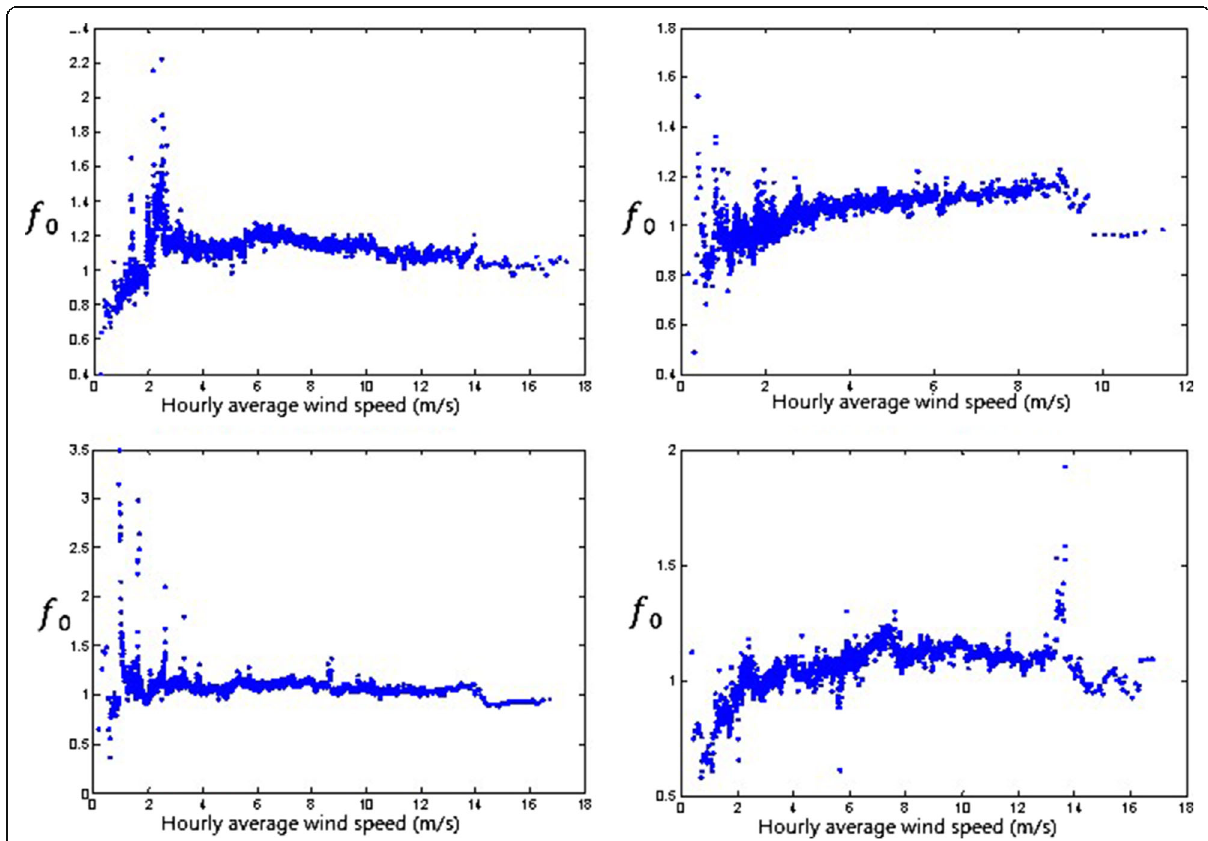
Fig. 7 Relationship between spectral characteristic and average wind speed